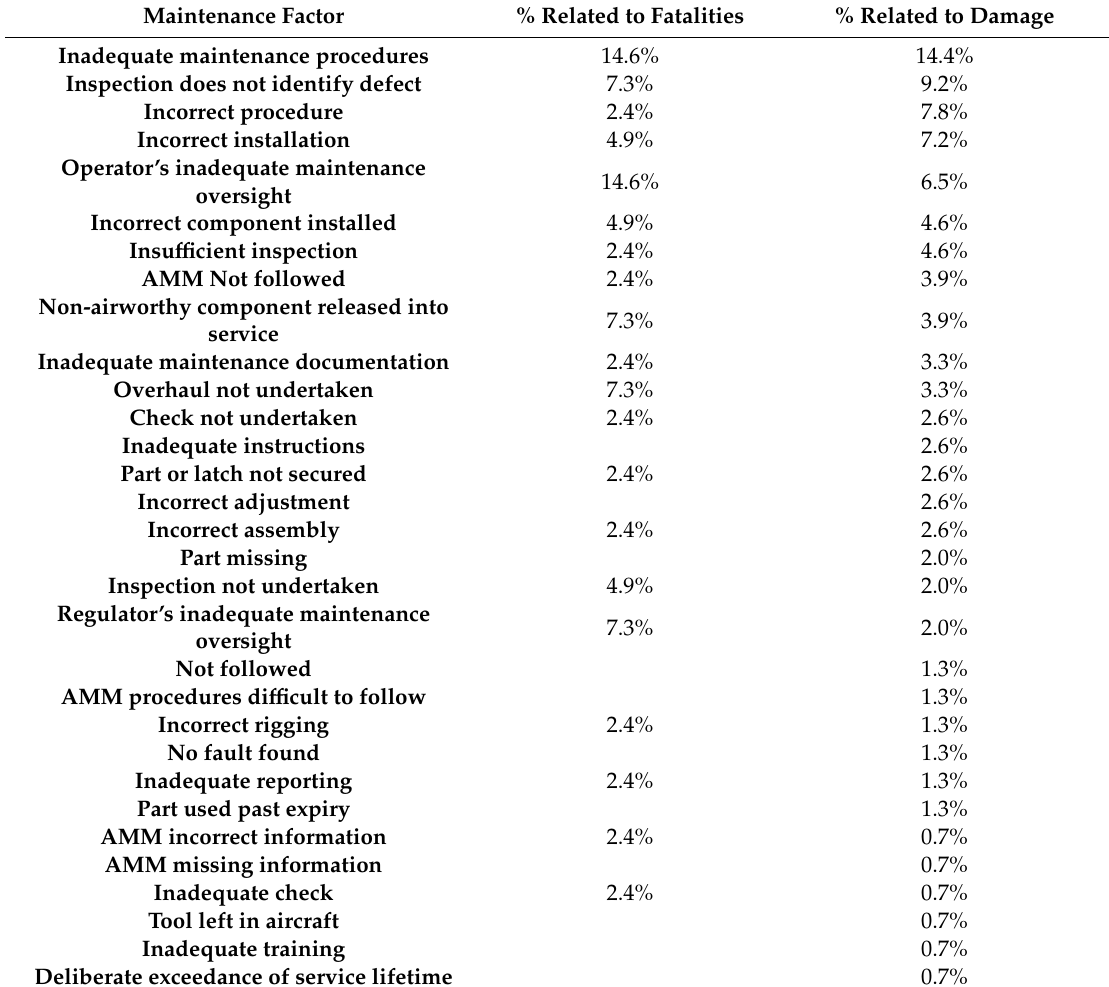
Table 9. Breakdown of maintenance factors related to fatalities and aircraft